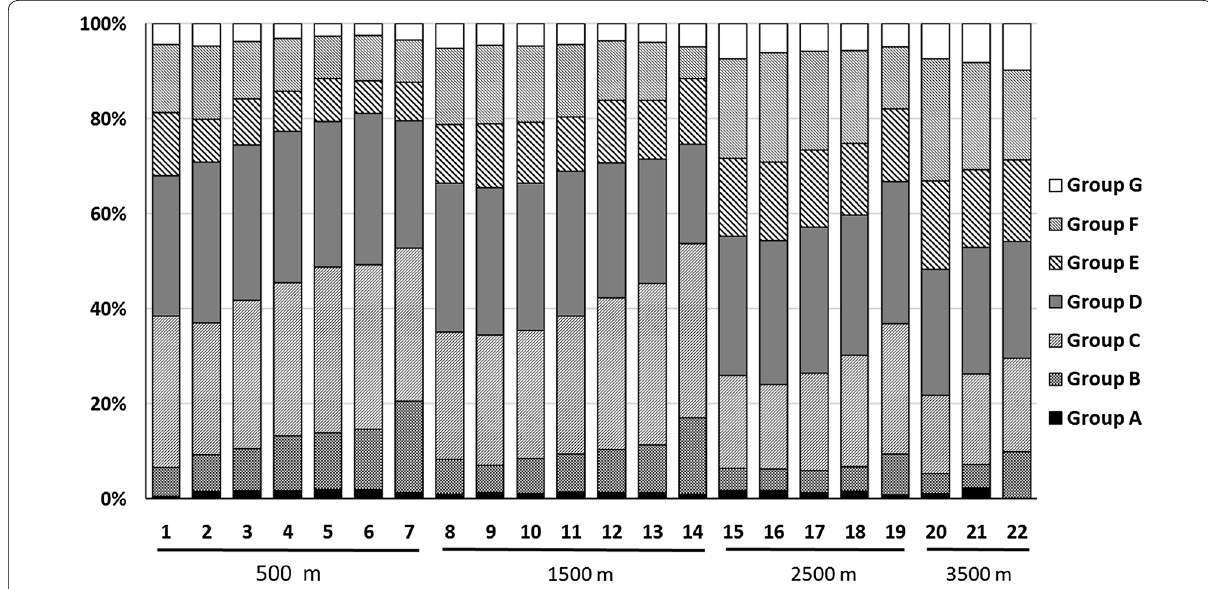
Fig. 5 The proportions of angiosperms with seven geographical distribution groups show different trends among geographical localities of Taiwan (GLTs). Angiosperms with tropical and subtropical distribution are dominant members in all the GLTs. The proportions of angiosperms with tropical distributions (Group B, C and D) increase from northern to southern Taiwan but decrease from low to high elevations. The proportions of angiosperms with subtropical distributions (Group E and F) present opposite trends to that with tropical distributions. Angiosperms with temper‑ ate distribution (Group G) are not dominant members of GLTs at higher elevations. The numbers at X axis are the numbers of GLTs listed in Fig. 1. At bottom of the figure , four lines and four numbers below the lines represent the upper altitudinal limits of